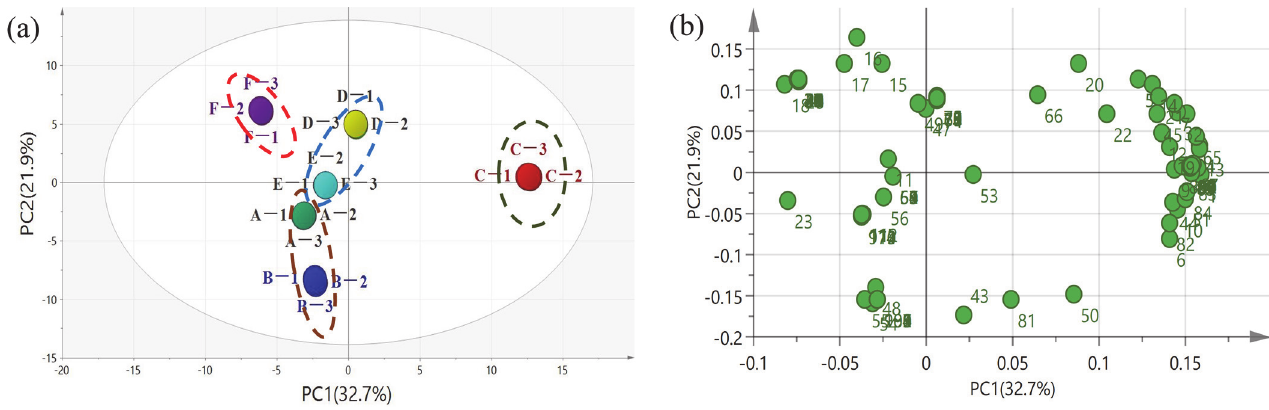
Figure 2. PCA analysis based on volatile compounds. ( a ) Scores and ( b ) loading plot of PCA for classification of samples of strong-flavor daqu with different production durations. The specific compounds represented by the numbers are shown in Table S1. A, B, C, D, E, and F represent samples from different periods, respectively.